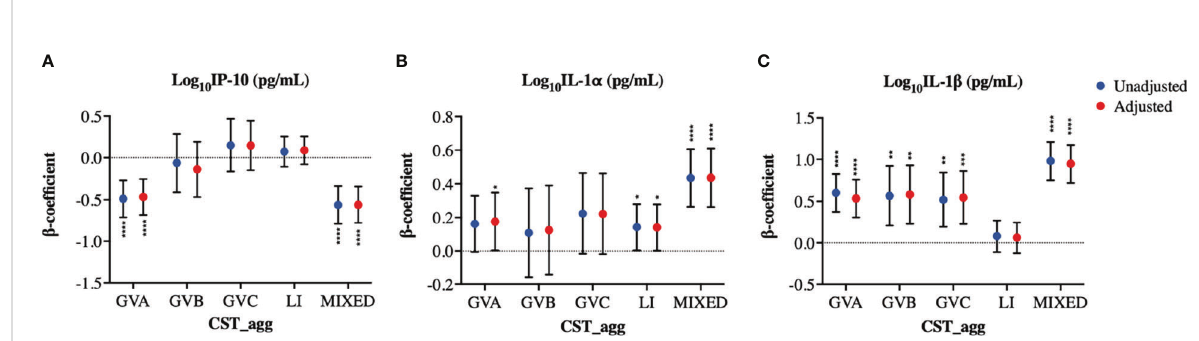
FIGURE 4 Cervicovaginal microbiome associations with log10-normalized BV-associated cytokines. Linear mixed model estimates for microbiome associations with (A) IP-10, (B) IL-1 a , and (C) IL-1 b log10-transformed concentrations in pg/mL. b -coef fi cients represent the estimated mean change in cytokine concentrations associated with a speci fi c CST_agg when using Lactobacillus (non-iners) dominant CST_agg as reference. Blue symbols represent unadjusted models only utilizing microbial groupings as predictors. Red symbols represent models following multivariable adjustment for hormonal contraceptive type, concomitant vulvovaginal candidiasis, age, HSV -2 seropositivity at baseline, use of BV antibiotics, use of other antibiotics, and use of antifungals prior to sample collection. The error bars represent the 95% con fi dence intervals associated with the estimates from the linear mixed models. *P ≤ 0.05, **P ≤ 0.01, ***P ≤ 0.001, ****P ≤